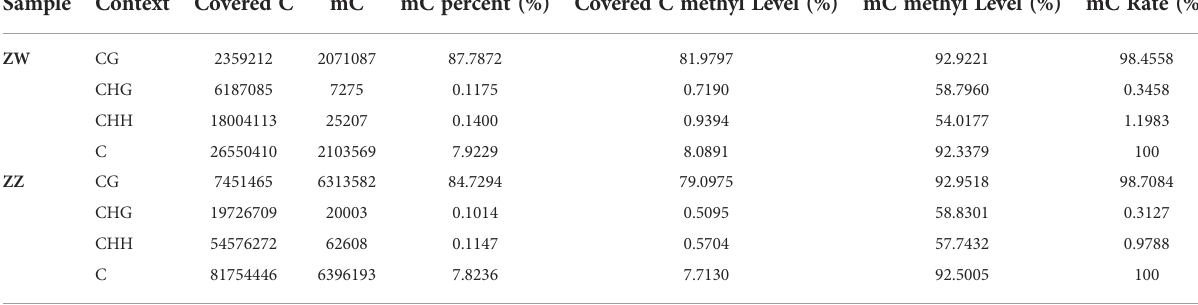
TABLE 1 Statistical results of methylation site test..